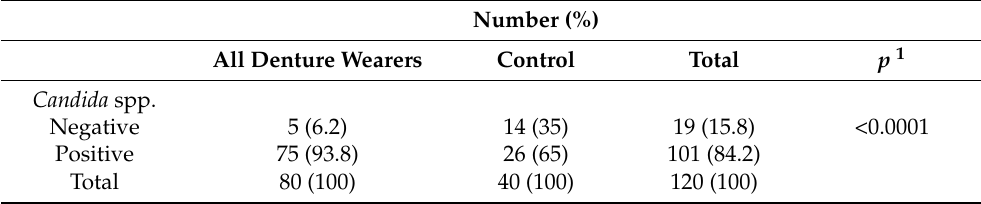
Table 2. Oral Candida colonization in